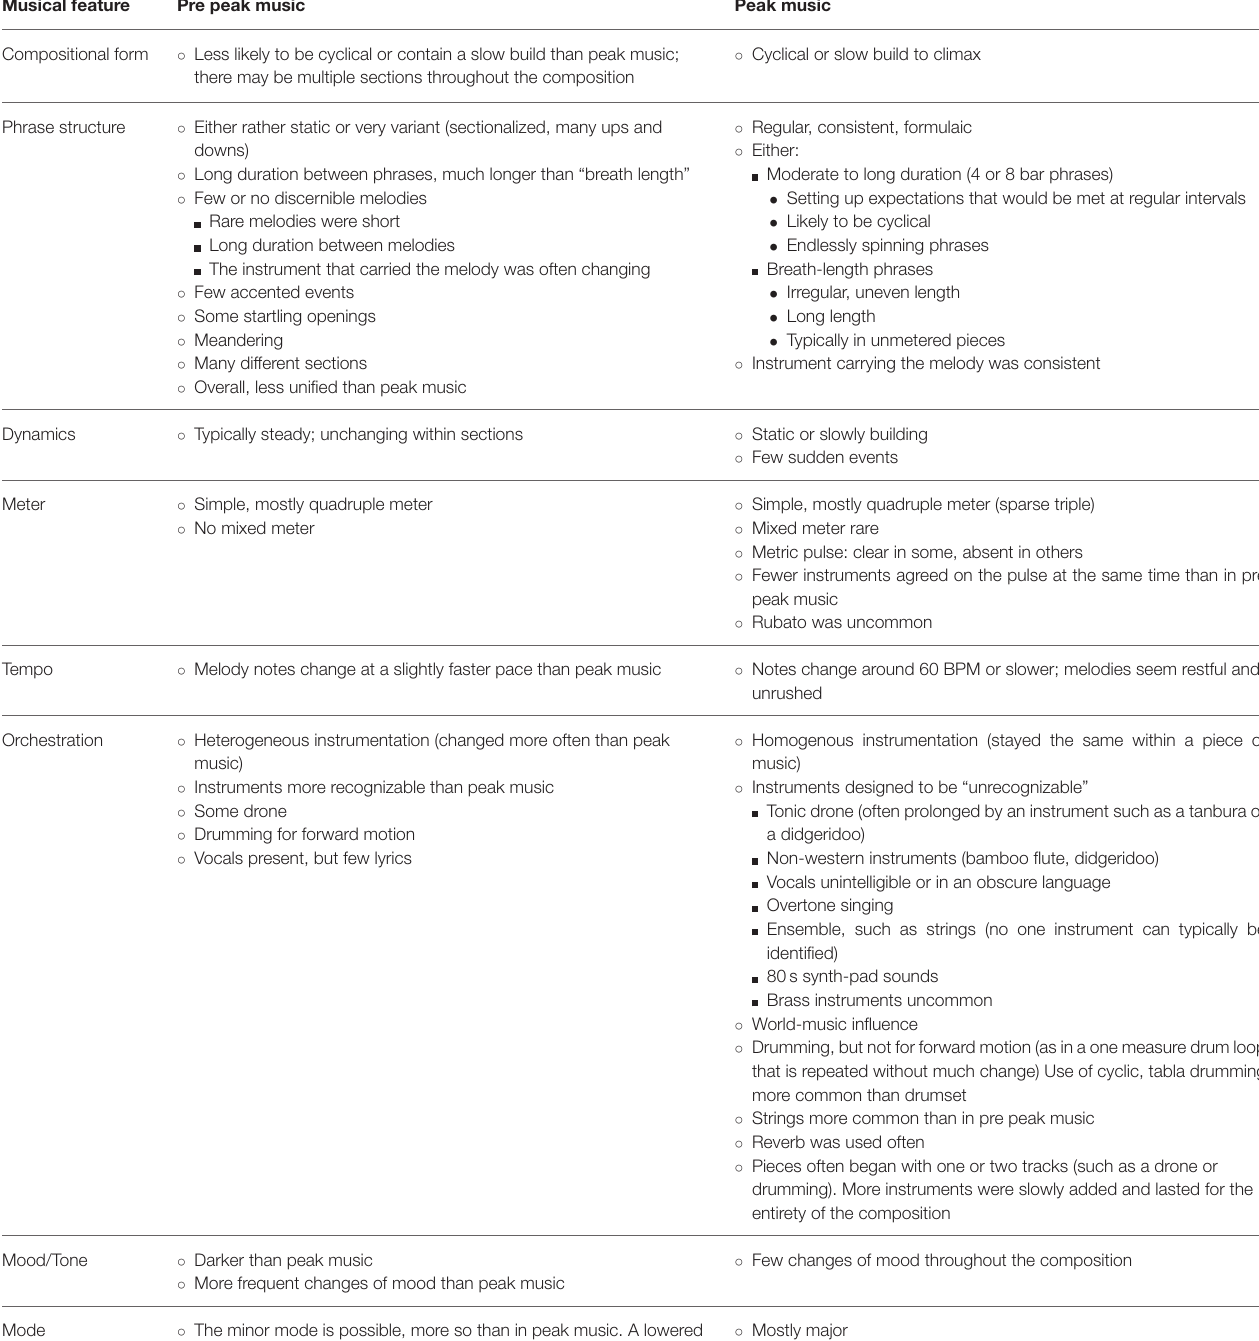
TABLE 1 | Qualitative features of pre peak and peak